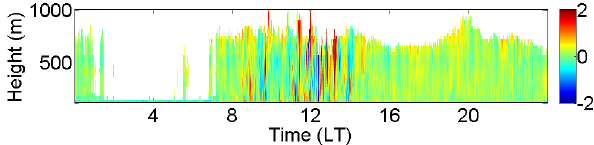
Fig. 4. An example of the daily vertical velocity field as recorded on 15 April 2008. The colour scale is ms − 1 , the horizontal axis is LT and the temporal resolution is 13s (observation time of 2s and 11s of processing time). The vertical axis is height (a.g.l.) in 26Figure 4. An example of the daily vertical velocity field as recorded on 15 th April 2008. The colour scale is ms -1 , the horizontal axis is LT and the temporal resolution is 13 seconds (observation time of 2 seconds and 11 seconds of processing time). The vertical axis is height (agl) in meters.